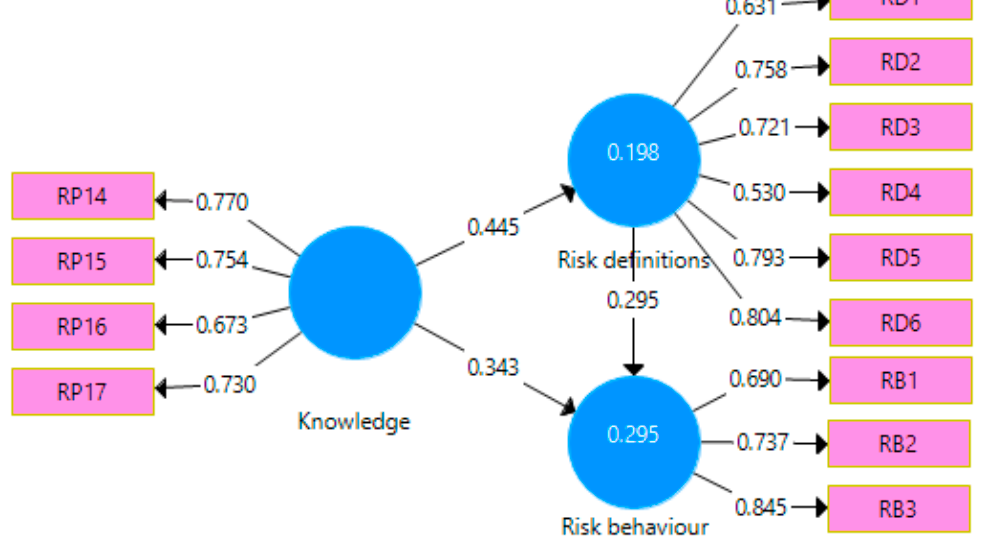
Figure 5. Model Four Structural Path Graph.